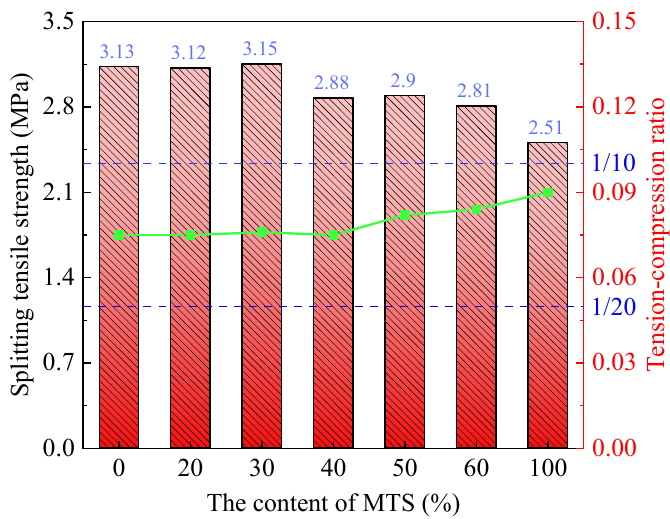
Figure 7. Effect of MTS content on splitting tensile strength and tension–compressive ration of MTSC.